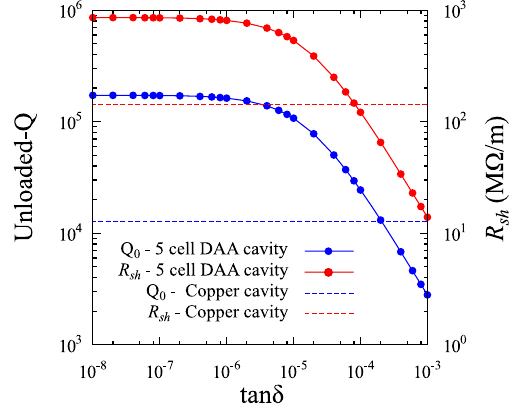
FIG. 10. Unloaded quality factor and shunt impedance of the 5 cell DAA cavity as a function of loss tangent of a dielectric